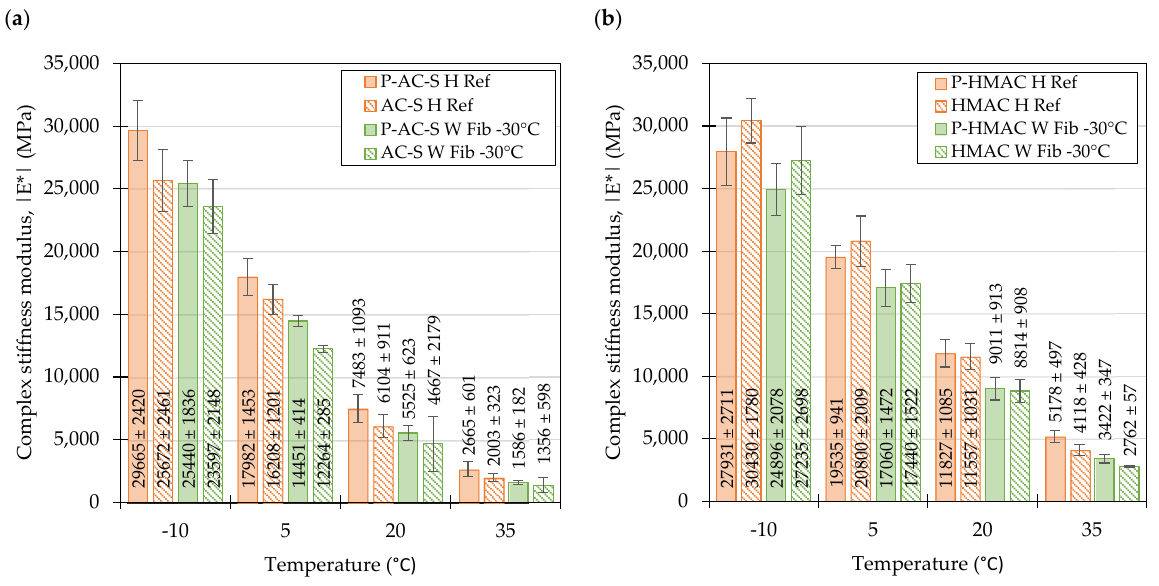
Figure 11. Complex stiffness moduli of plant produced surface course ( a ) and high modulus asphalt concrete mixtures ( b ) measured at 10 Hz; means and 95% confidence intervals (also shown as error bars). Table 6. Results of post-hoc Tukey HSD tests (p-values) for assessment of differences between the dynamic moduli (|E*|) in mixture pairs; p-values < 0.05 denote significant differences in pairs.